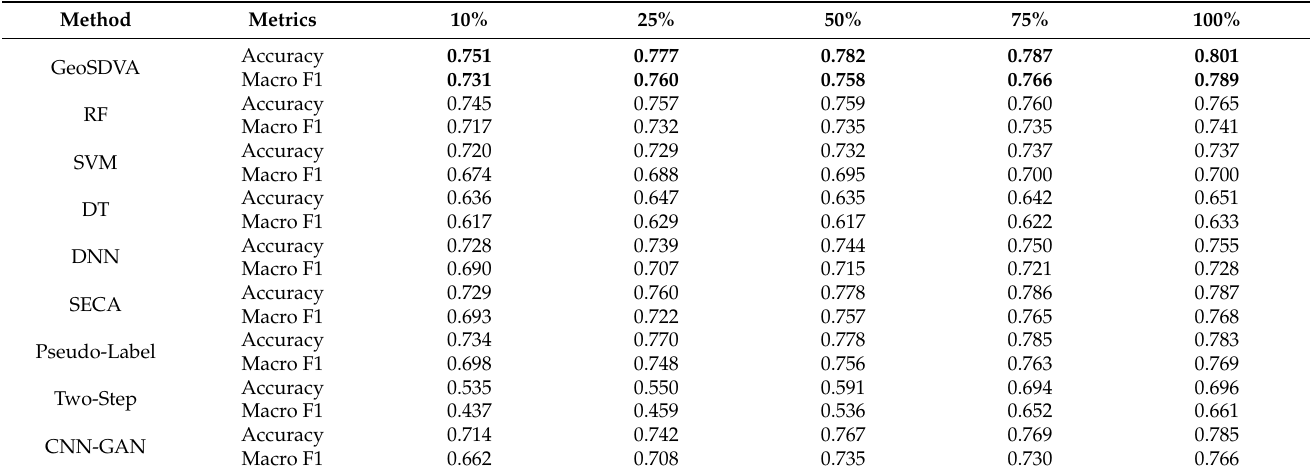
Table 5. The performance of different models on the Geolife dataset.